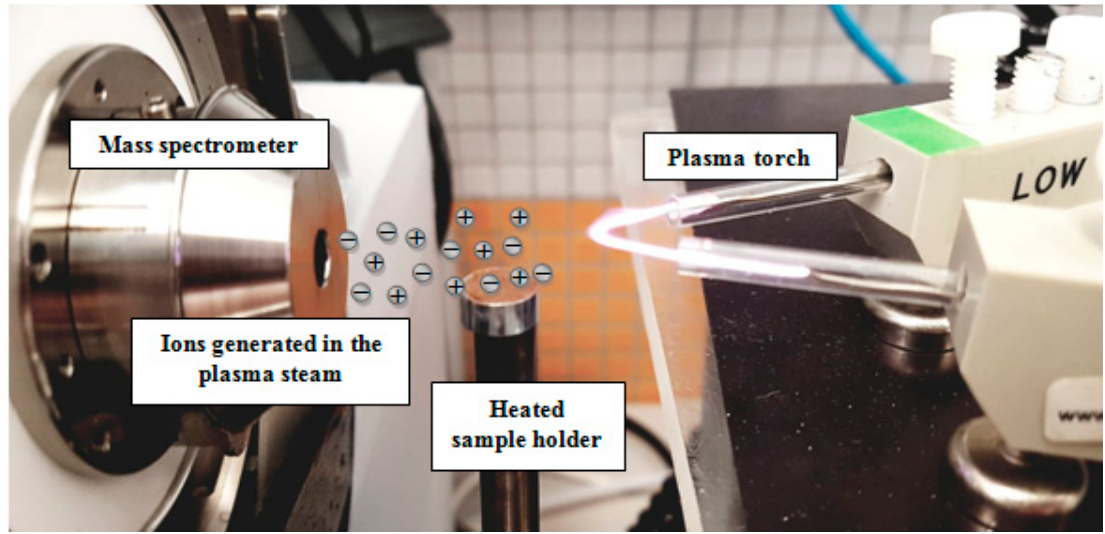
Figure 3. The measuring system: plasma torch, heated sample holder, and amaZon SL mass spectrometer.